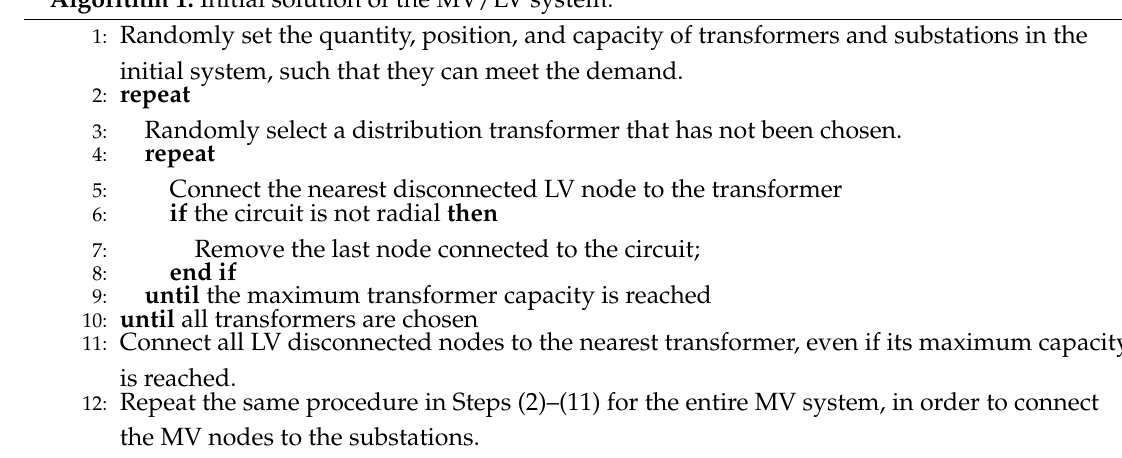
Algorithm 1: Initial solution of the MV/LV